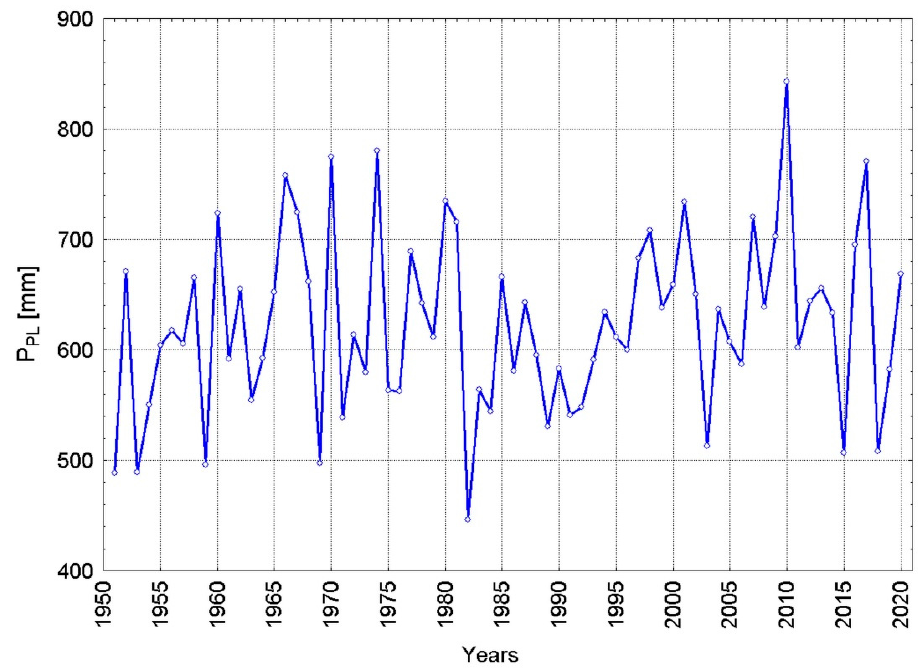
Figure 5. Course of the annual area precipitation (P PL ) in Poland in 1951–2020.